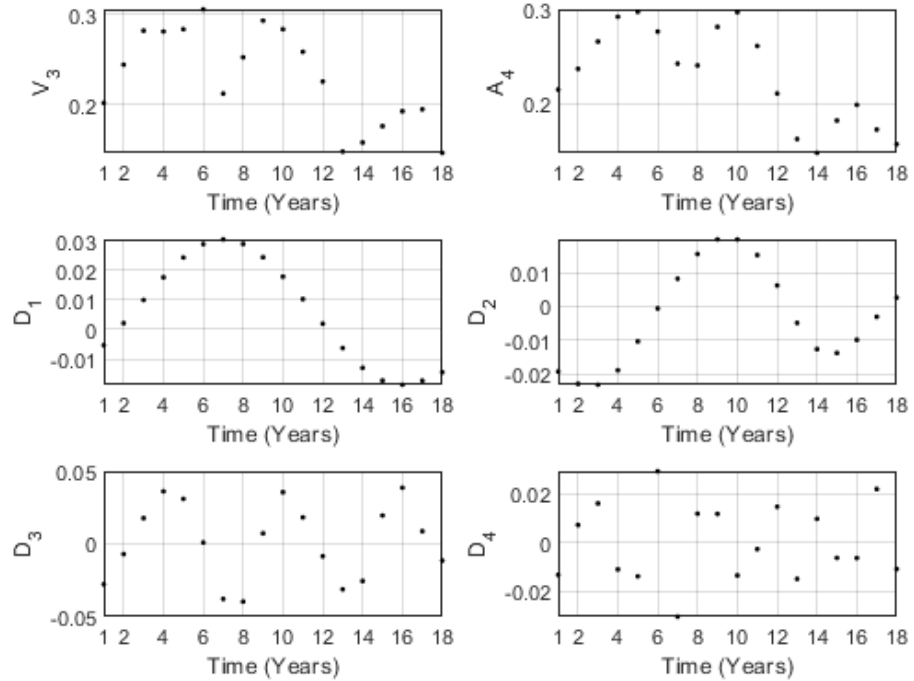
Figure 3. The wavelet decomposition of the variable V 3 at the level